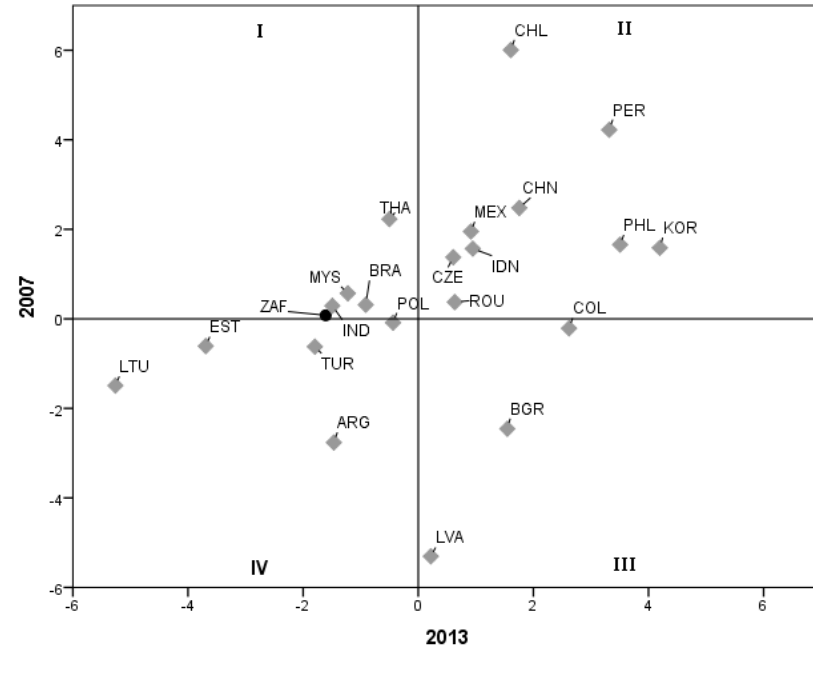
FIGURE 8: National ranking in terms of resilience indicator Source: Authors’ analysis of data from The World Bank: World Development